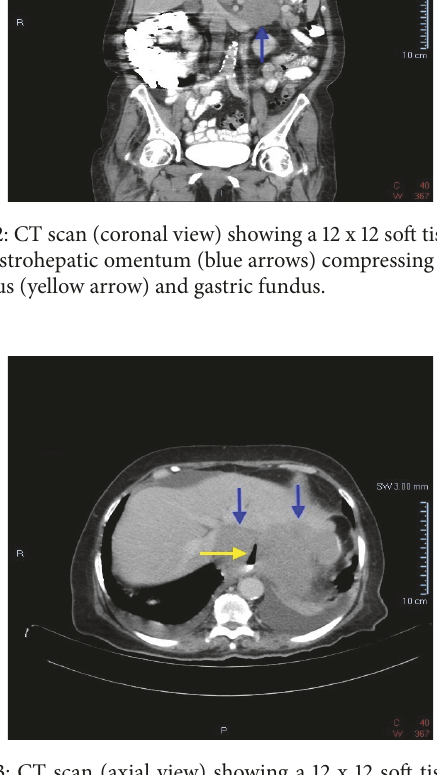
Figure 3: CT scan (axial view) showing a 12 x 12 soft tissue mass in the gastrohepatic omentum (blue arrows) compressing the distal esophagus (yellow arrow) and gastric